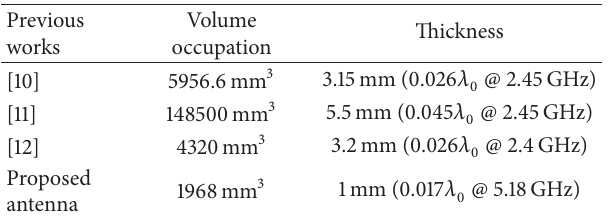
Table 1: Size comparison between previous repeater antennas and proposed